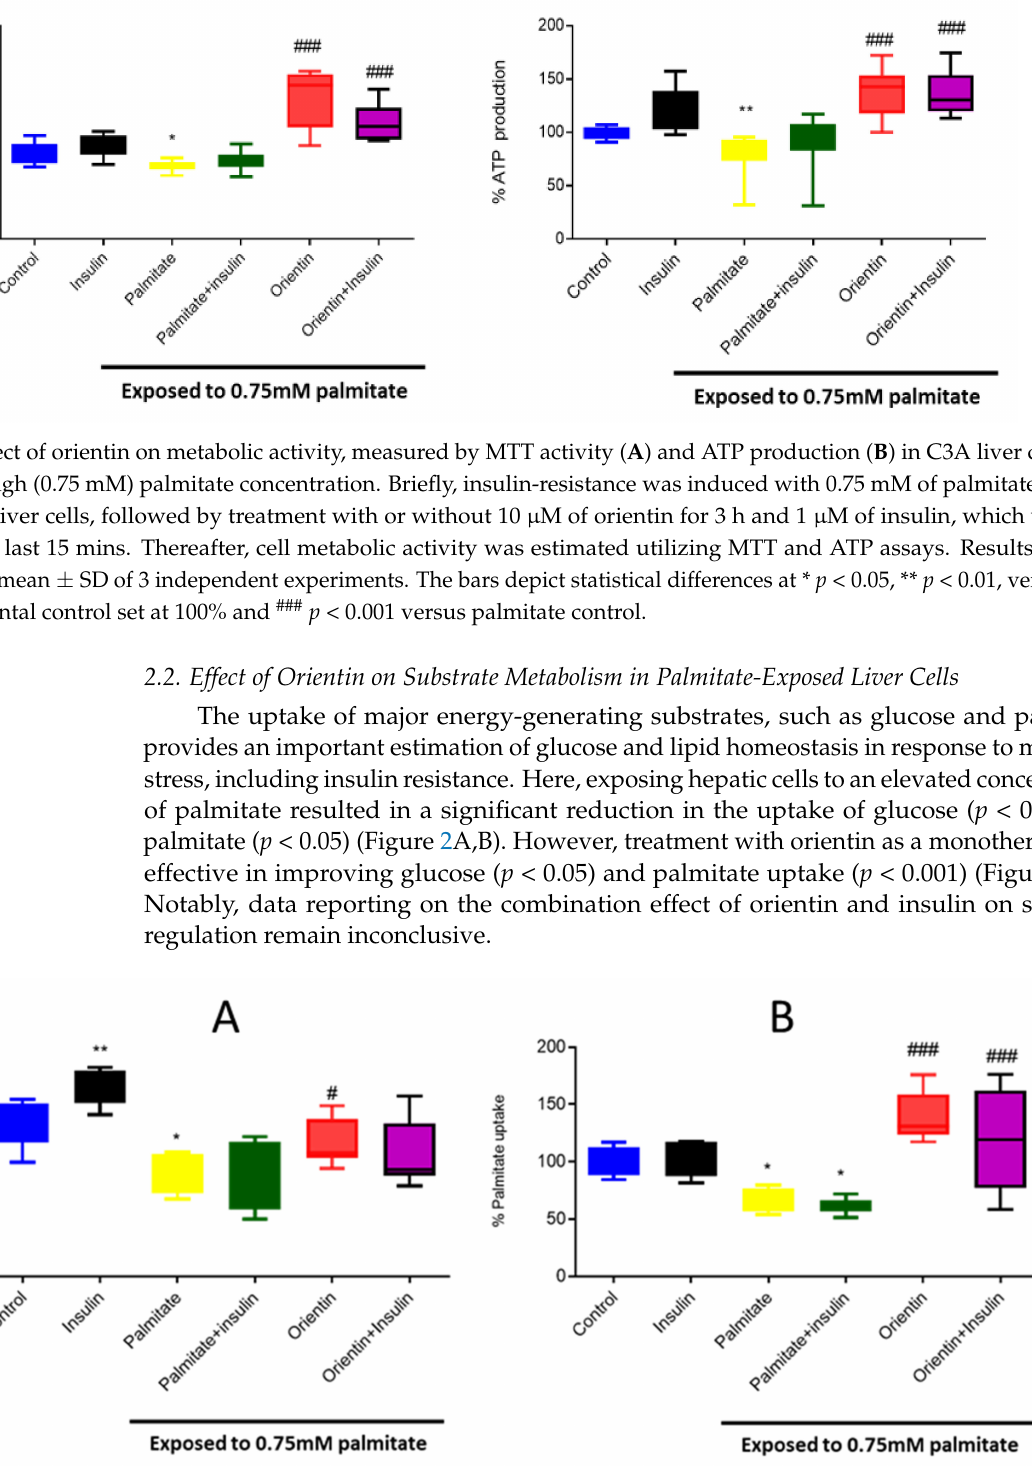
Figure 2. Effect of orientin on substrate utilization as measured by uptake of glucose ( A ) and palmitate ( B ) in C3A liver cells exposed to high (0.75 mM) palmitate concentration. Briefly, insulin-resistance was induced with 0.75 mM of palmitate for 16 h in C3A liver cells, followed by treatment with or without 10 µ M of orientin for 3 h and 1 µ M of insulin, which was added in the last 15 min. Thereafter, glucose uptake was measured using [3H]-2-deoxy-D-glucose and palmitate uptake was determined using 14C palmitate. Results are expressed as mean ± SD of 3 independent experiments. The bars depict statistical differences at * p < 0.05, ** p < 0.01, versus the experimental control set at 100% and # p < 0.05 and ### p < 0.001 versus the palmitate